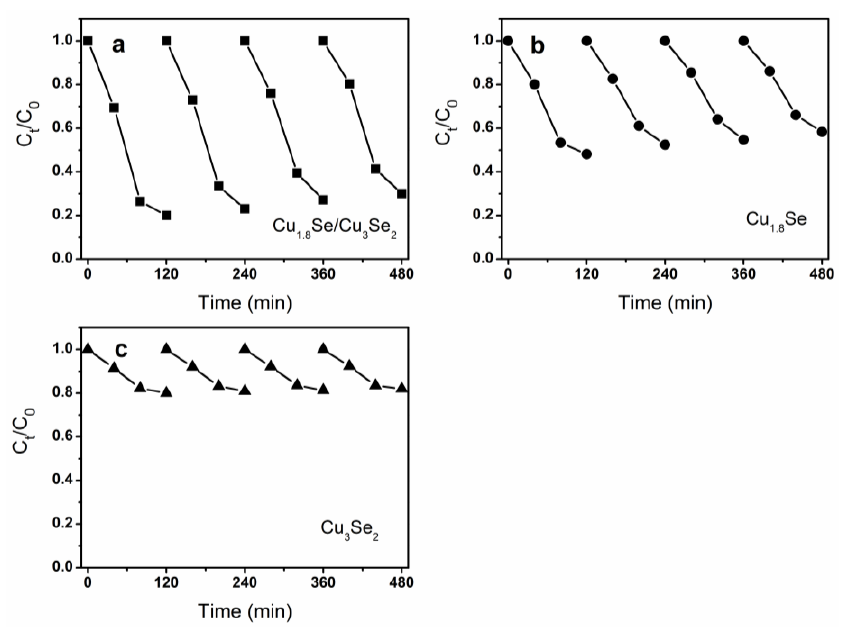
Figure 5. Cycling runs for the photocatalytic degradation of MO under full solar light in the presence of ( a ) Cu 1.8 Se/Cu 3 Se 2 composite; ( b ) Cu 1.8 Se; ( c ) Cu 3